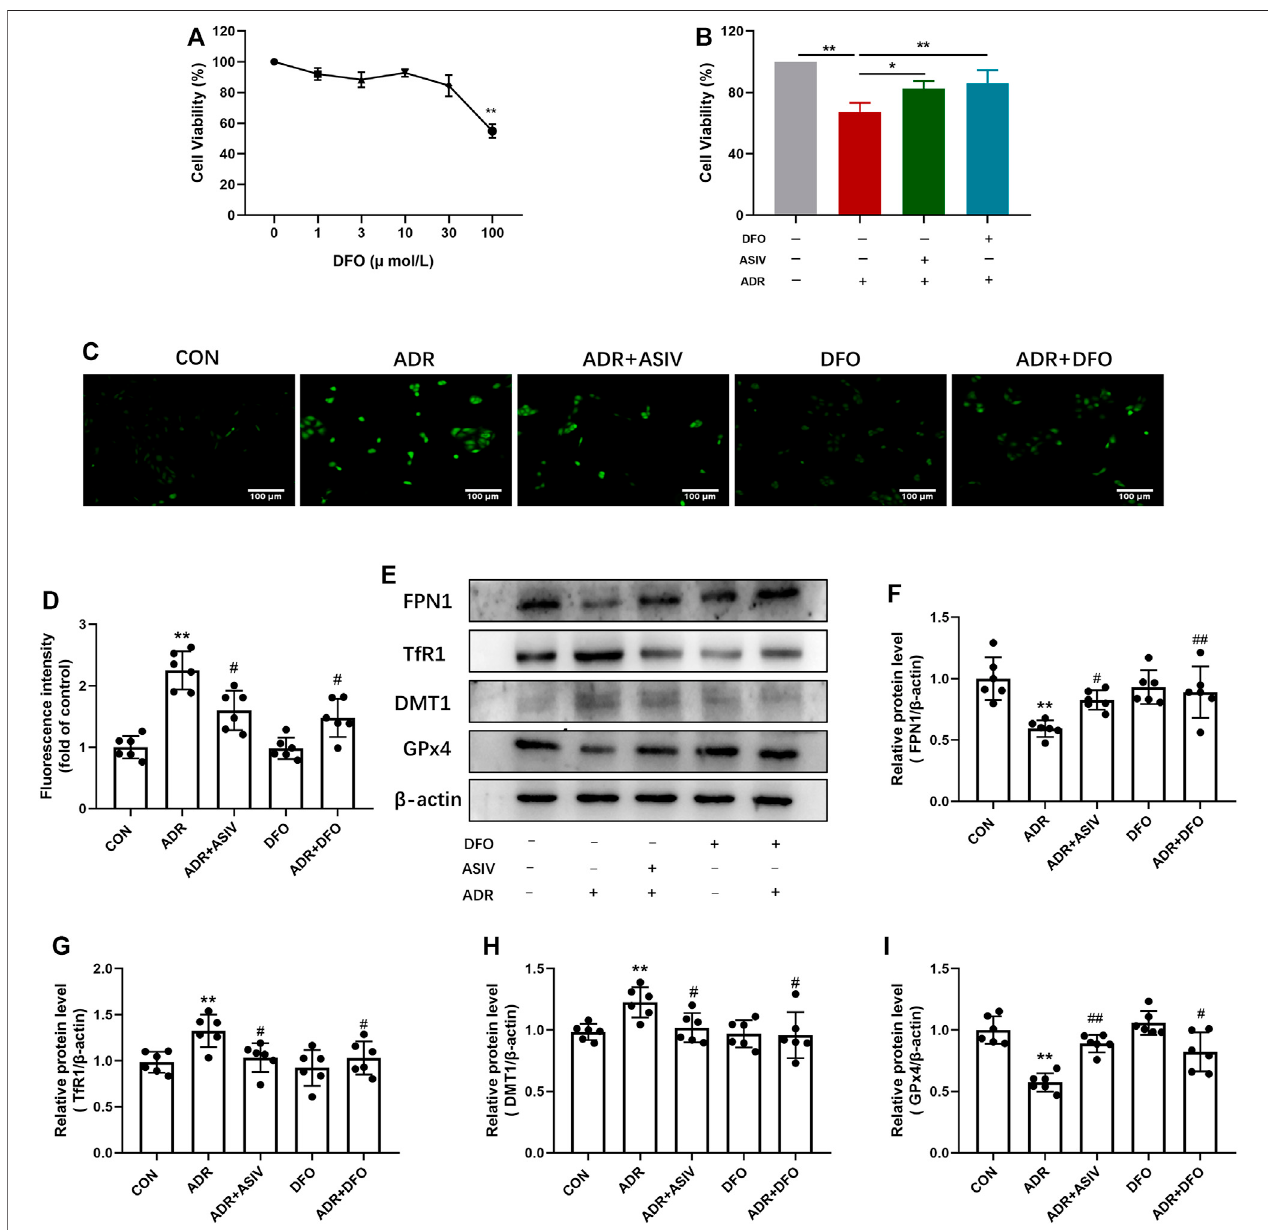
FIGURE6| ASIVcouldalleviateADR-inducedcytotoxicitybyreducingirondeposition. (A) After24 hofDFOtreatment,HK-2cellviabilitywastestedbytheCCK-8 assay. (B) DFO30 μ M+ADR1 μ Mgroupfor24 h.HK-2cellviabilitywasevaluatedbytheCCK-8assay. (C) ThecellularROSwasdetectedaftertreatmentandthechart. Representativeimage (D) andtheproteinlevelsofFPN1 (E) ,TfR1 (F) ,DMT1 (G) ,andGPx4 (H) inthekidneytissueinthesegroups.Datawereexpressedasmean±SD, n = 6. * p < 0.05, ** p < 0.01 vs. CON group. # p < 0.05, ## p < 0.01 vs. ADR group.